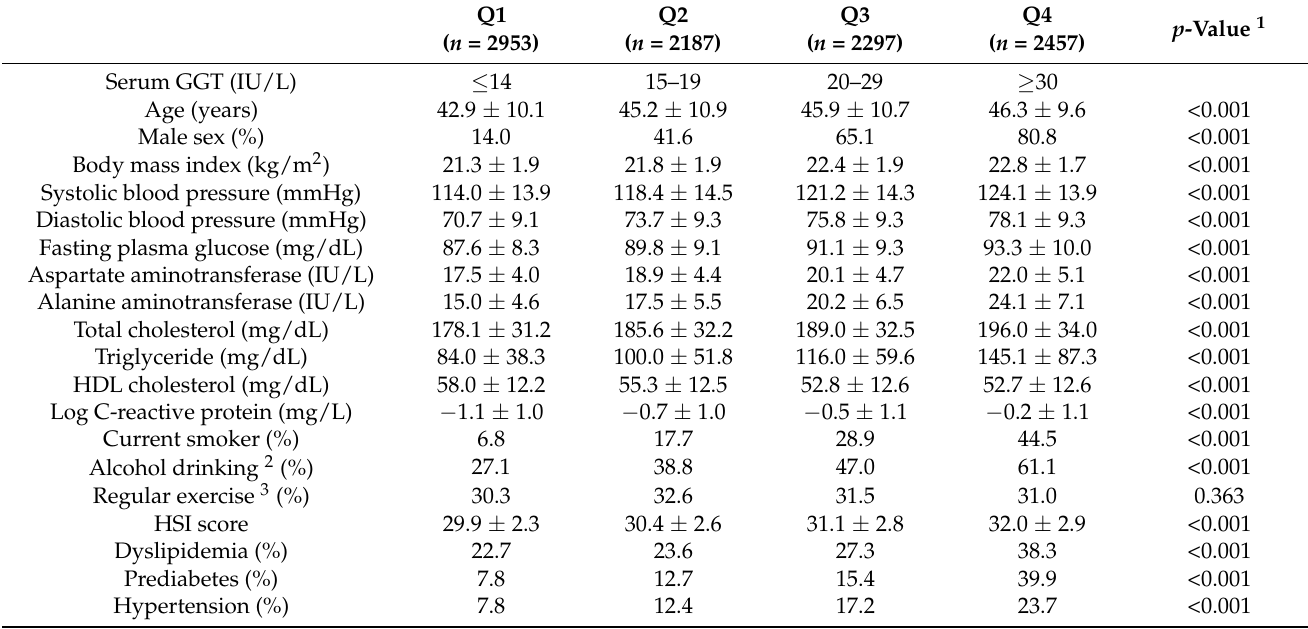
Table 1. Baseline characteristics of the study population.